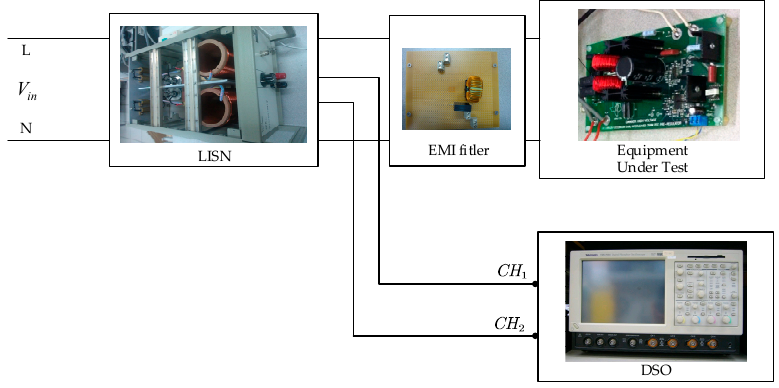
Figure 10. EMI measurement setup.